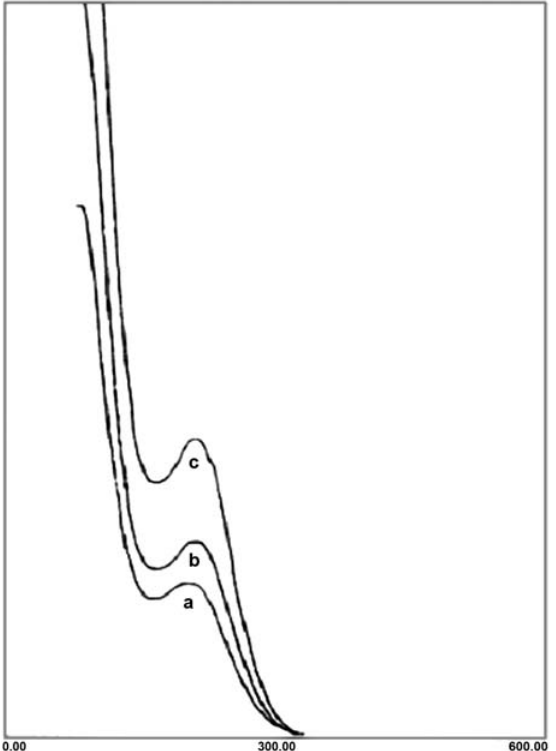
Figure 3. UV spectra of Preyssler (a), A (b) and B